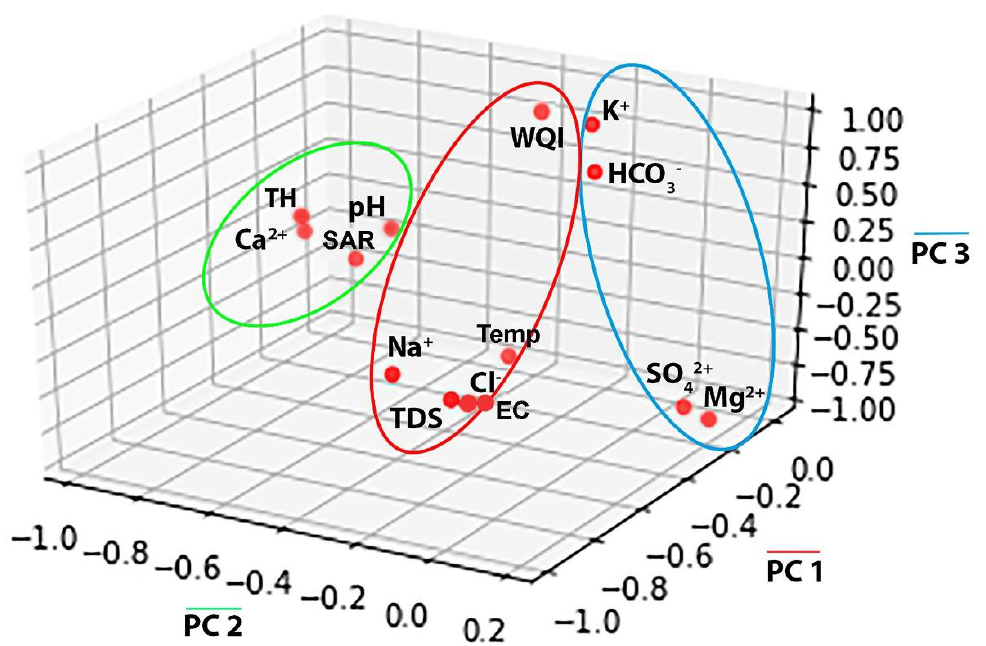
Figure 5. Screen plot from PCA loadings scores for dataset of water samples.